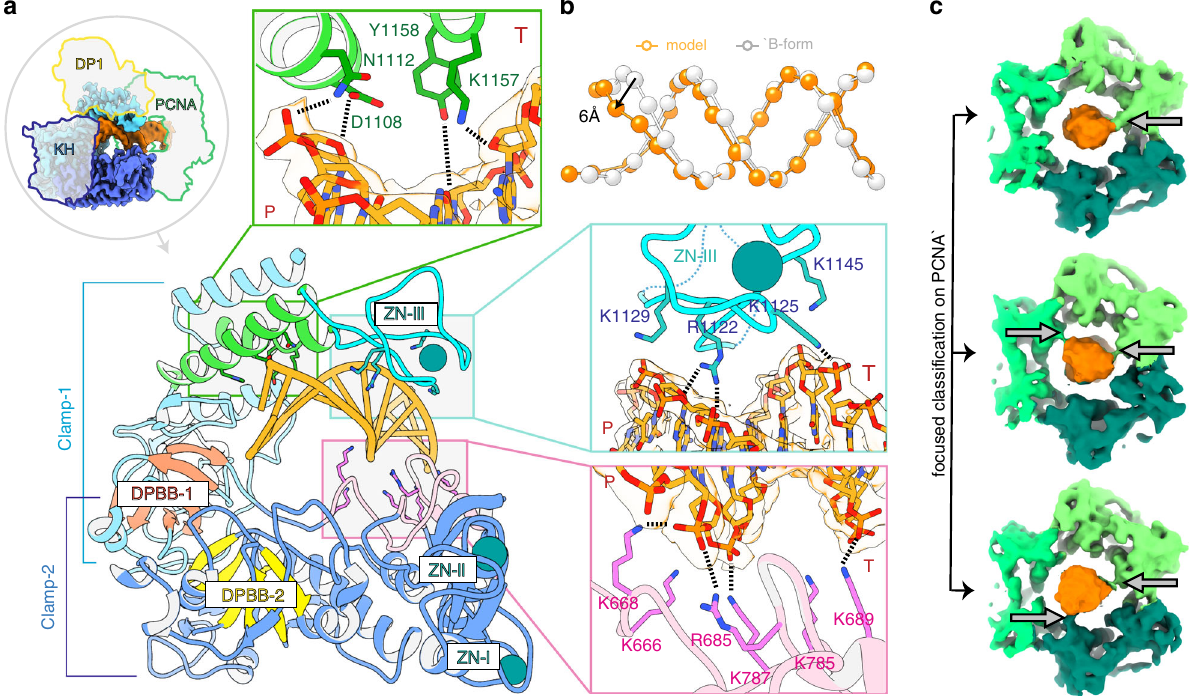
Fig. 2 Structural basis for DNA binding by the PolD – PCNA complex. a View of the DP2 clamp-1 (light blue) and clamp-2 (dark blue) domains surrounding one turn of the DNA duplex (orange). The two catalytic double-psi β -barrels DPBB-1 and DPBB-2 are represented in red and yellow, respectively. Template and primer strands are indicated by T and P, respectively. b Interaction with the PolD clamp causes a local distortion of the DNA (orange) compared with an ideal B-form DNA (white). The phosphates of the DNA duplexes are shown as spheres. c PCNA makes labile contacts with DNA. Focused classi fi cation on PCNA resulted in three 3D classes showing extra-densities between DNA and PCNA residues K84 and K86, which are underlined by